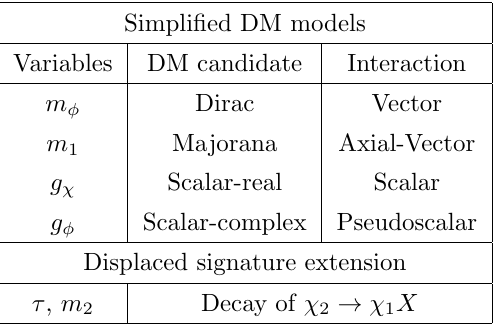
Table 1 . Overview of the di(cid:11)erent building blocks that form simpli(cid:12)ed DM models. The lower part of this table lists the kinematic variables, lifetime ( (cid:28) ) and mass ( m 2 ) of the excited state (cid:31) 2 and its decay (cid:31) 2 (cid:31) 1 X , which are required to add the displaced signature to the standard simpli(cid:12)ed ! DM models.